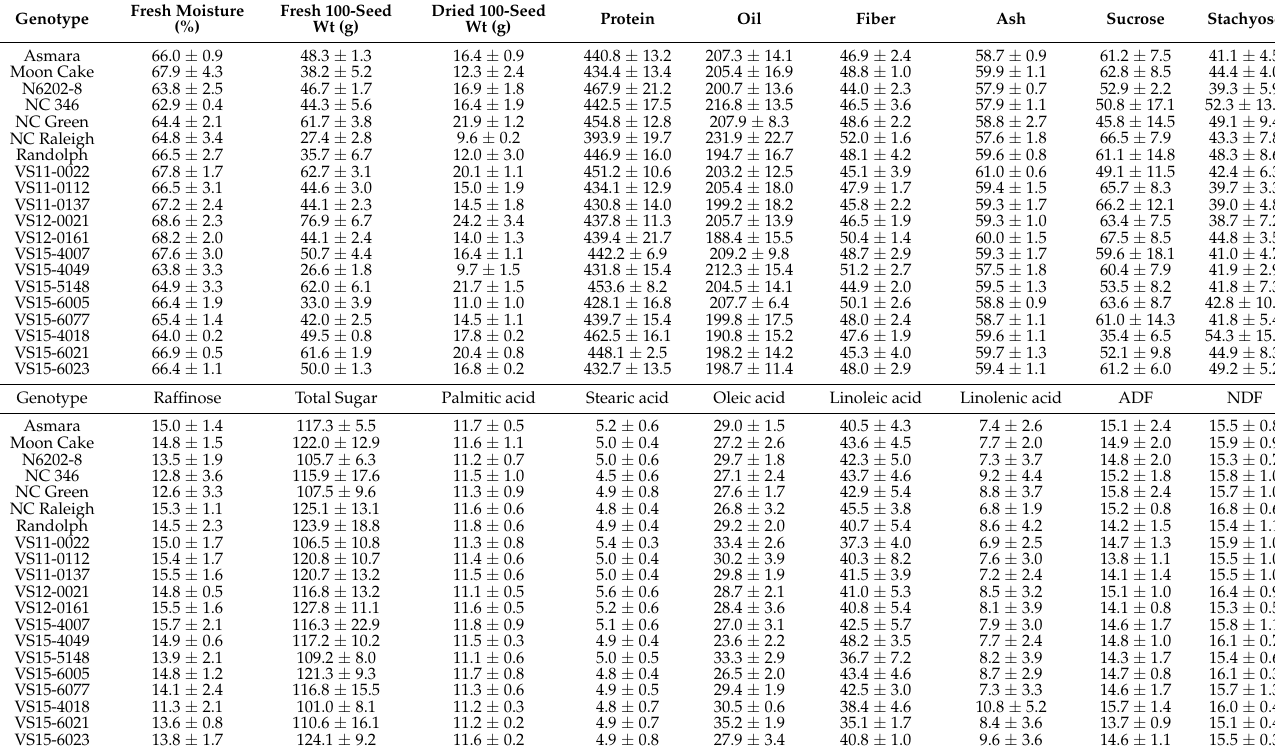
Table 1. Average performance of 20 edamame cultivars and lines in seed size and composition traits across three years (2018–2020). Protein, oil, fiber, ash and sugars are presented as mg g − 1 on dry weight basis; fatty acids are presented as percentage of oil (total fatty acid); and acid detergent fiber (ADF) and neutral detergent fiber (NDF) are shown as percentage of dry seed weight,